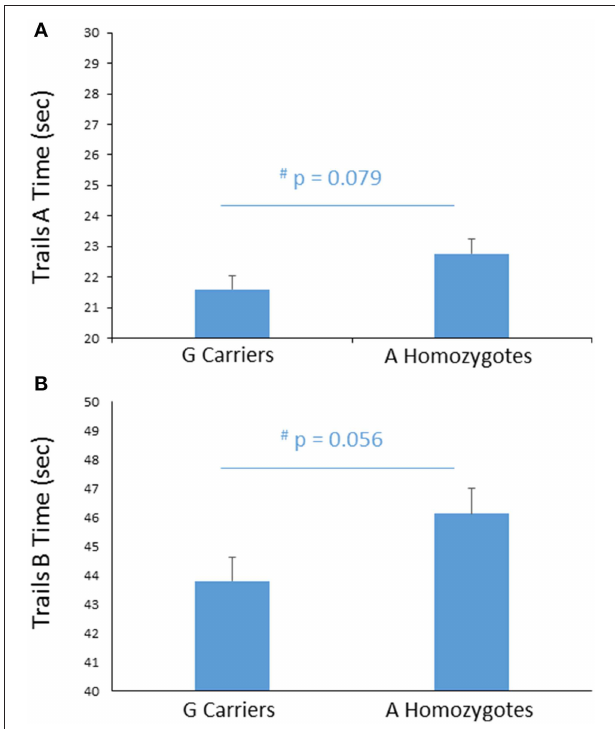
FIGURE 4 | Effects of FREM3 rs7676614 genotype on TMT performance. Relative to G carriers, A allele homozygotes showed a trend toward slower performance in both Part A (A) and Part B (B) of the TMT. Error bars represent standard error of the mean. * p < 0 . 05 , # p < 0 . 10